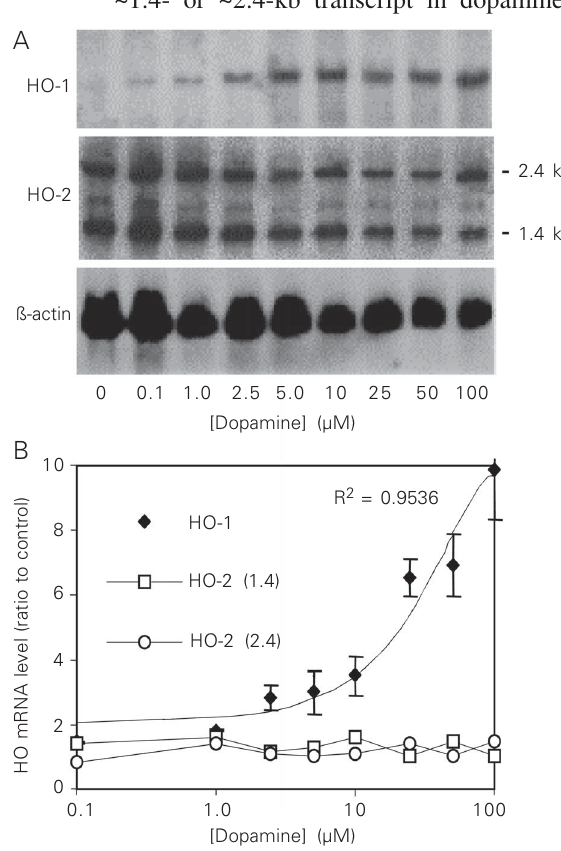
Figure 1. Effects of exposure to dopamine on the levels of heme oxygenase 1 and 2 (HO-1 and HO-2) mRNA in SK-N-SH cells. A , Northern blot analysis. Cells were treated for 24 h with increasing concentrations of dopamine (0.1-100 µM). B , Relative expression levels of HO-1 mRNA. Data are reported as means ± SEM (N